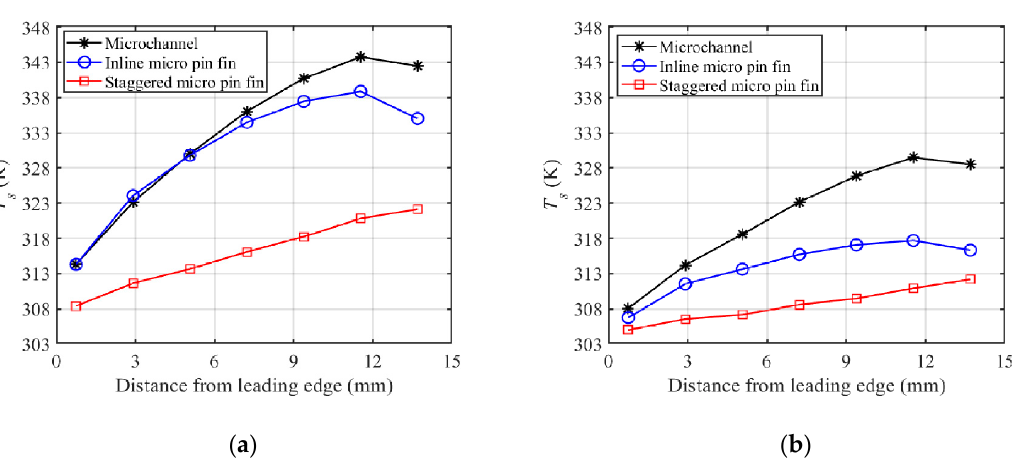
Figure 8. Temperature distributions along the centerline of the simulated power IC at ( a ) Re = 339.3, ( b ) Re = 678.7.